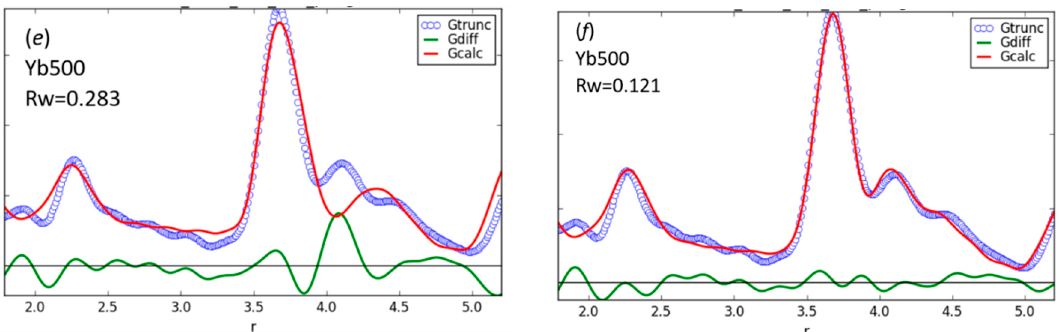
Figure 6. Modelling of X-ray PDF data on three compositions using long-range ( panels a, c, and e ) and two-phase model ( panels b, d, and f ). Empty circles: Experimental data; red solid line: Calculated; blue solid line: Difference curve.